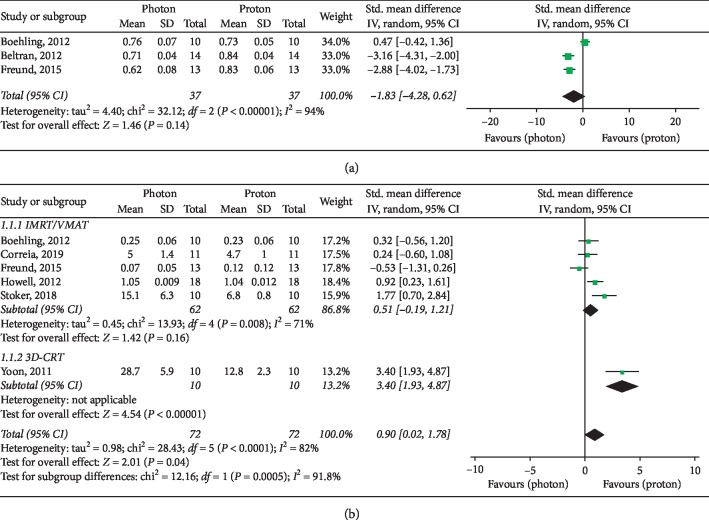
Target conformity and homogeneity. (a) Conformity Index. (b) Homogeneity Index.